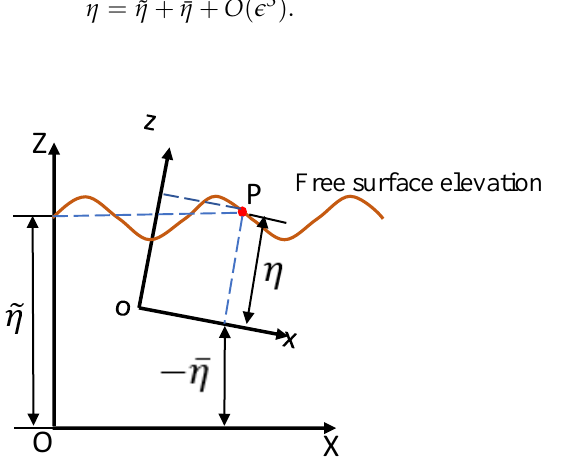
Figure 2. Definition of the free-surface elevations observed in OXYZ and oxyz